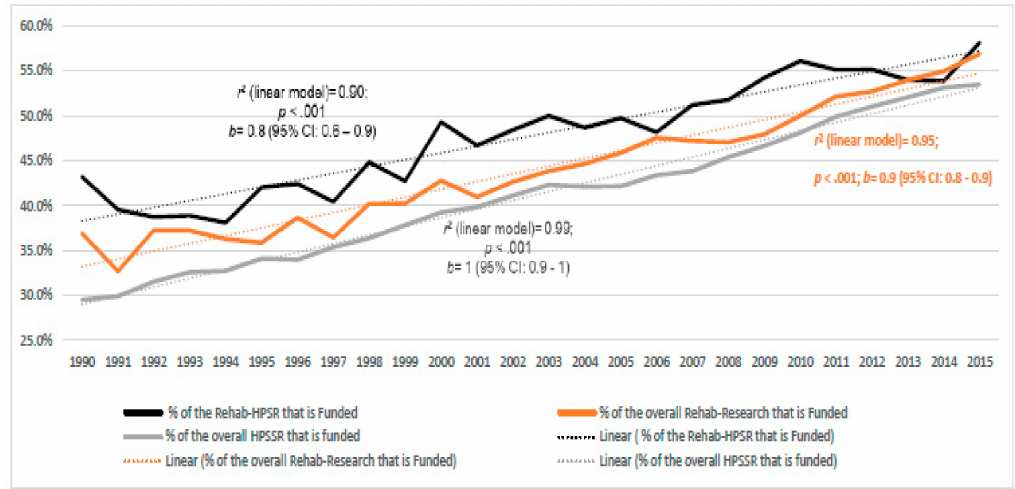
Figure 5. The yearly percentage of the research publications that were funded for the rehab (i.e., rehabilitation) Health Policy, Systems and Service Research (HPSSR), the overall rehab research, and the overall HPSSR (1990–2015), and the regression models that had the best fit with the data. The p values and 95% Confidence Intervals (CIs) refer to the linear regression